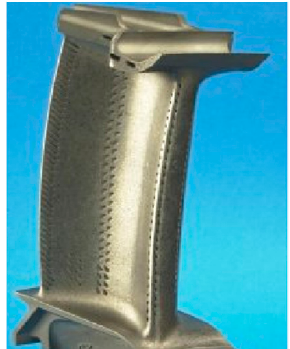
Figure 2. The turbine blade surface with film cooling holes [6].